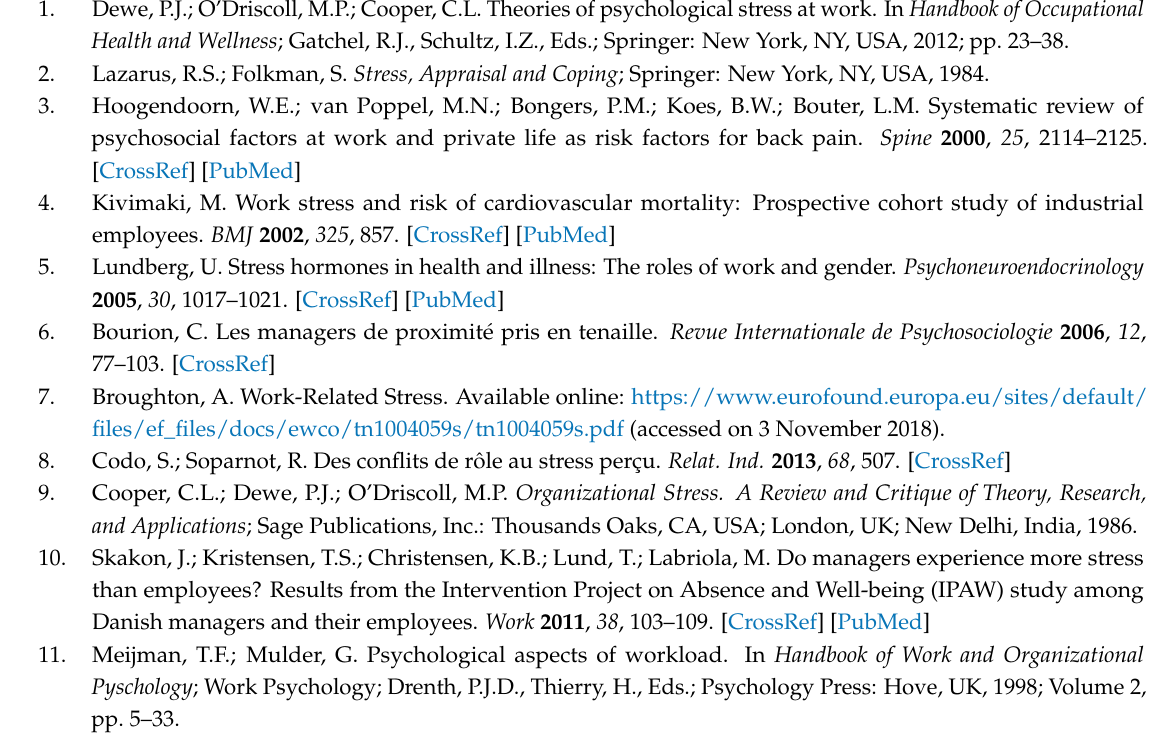
Table S1: CONSORT 2010 checklist of information to include when reporting a randomised trial. Acknowledgments: We would like to thank the Government of the County of Tyrol, the Tirol Werbung, the Propter Homines Foundation (Liechtenstein), and the Best Alpine Wellness Hotels for their generous support and funding. Additionally, we would like to thank our study